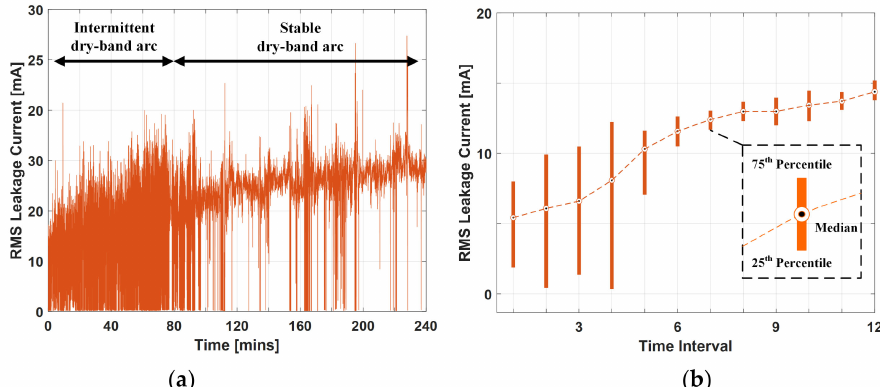
Figure 4. ( a ) Root-mean-square (RMS) leakage current for a GS10 filled silicone rubber (SiR) sample during the +DC IPT and ( b ) corresponding statistical boxplot representation for the first 12 20-min time intervals, first 240 min, of the